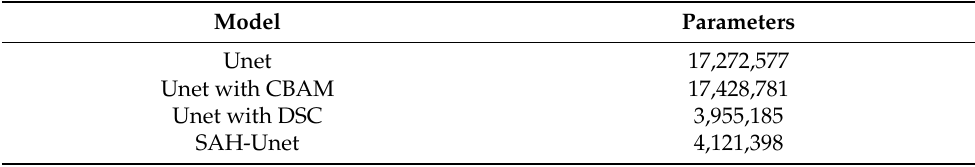
Figure 8. Depthwise-separable convolutions schematic diagram. It consists of two parts: depthwise convolution and pointwise convolution. Depthwise convolution uses only one convolution core for each channel. Pointwise convolution performs 1 × 1 convolution on all channels. Table 1. Comparison Table of Model Parameters.